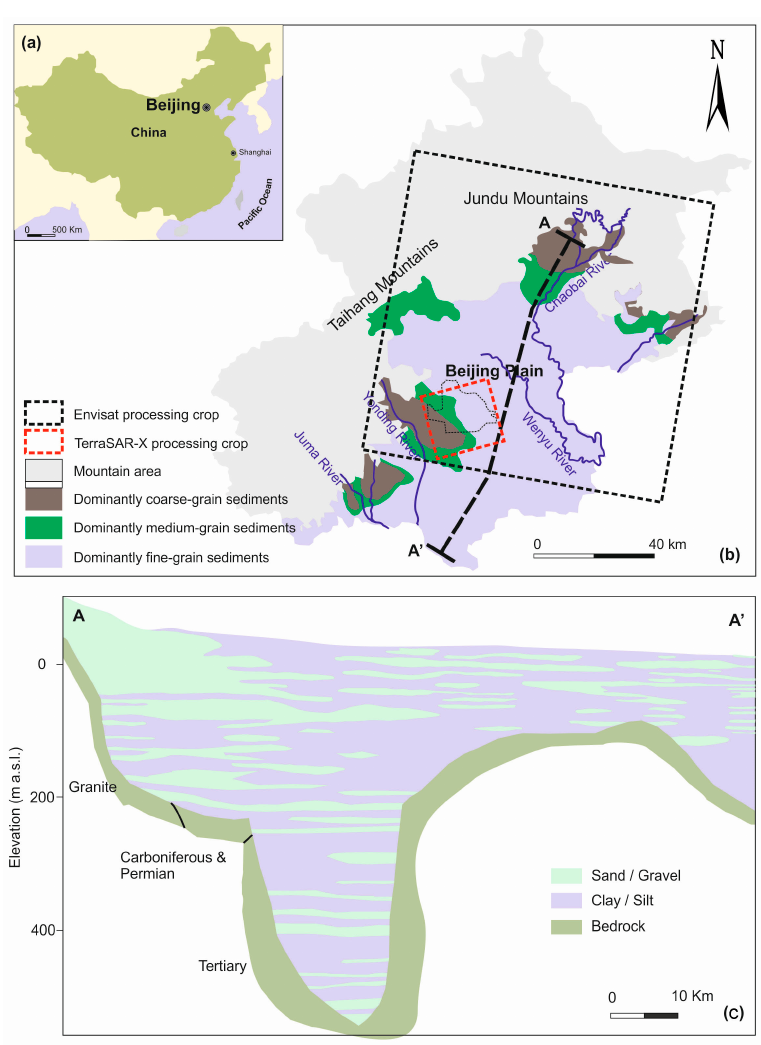
Figure 1. ( a ) Location of the study area; ( b ) geology of the Beijing plain (China); ( c ) hydrogeological cross-section of the studied aquifer (adapted from [20]).